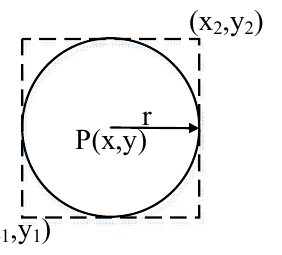
Figure 9. Circle query to the rectangular range query.